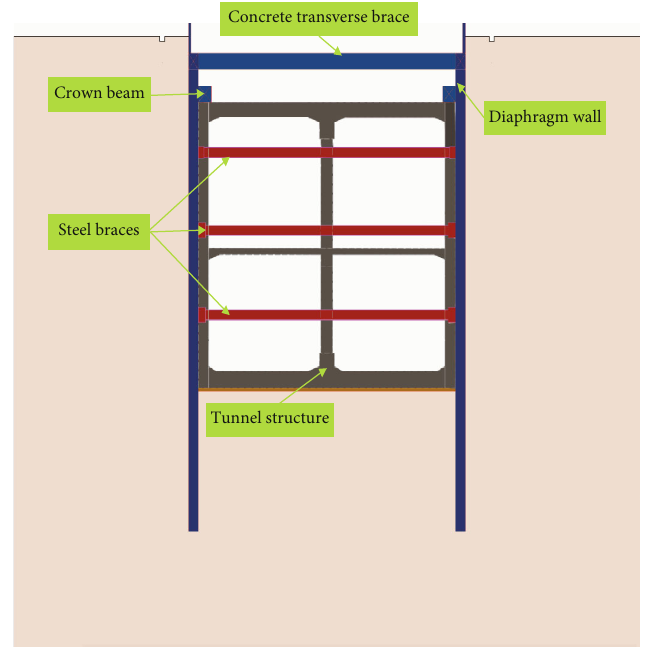
Figure. 2: Diagram of the Jinan Yellow River Tunnel support structures.